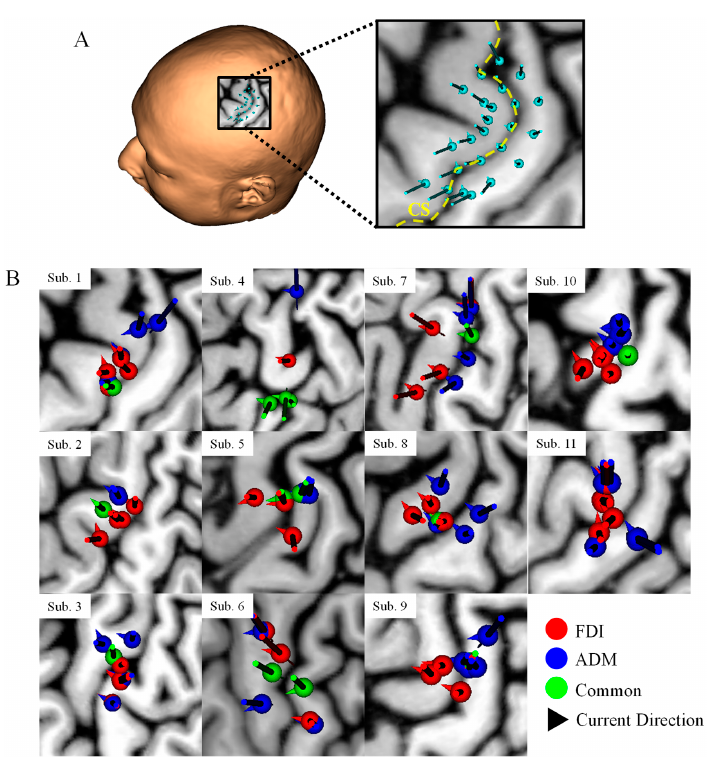
Figure A1. ( A ) TMS coil positions and orientations over the hand knob. The yellow dotted line indicates the central sulcus (CS). ( B ) Projection of the coil positions on the cerebral cortex that elicited the highest five MEPs for each participant. Red and blue dots represent the FDI and ADM, respectively. Green dots indicate the samples that were common to the two muscles. Arrows indicate the coil orientation. There is not clear distinction between the two target muscles based only on the coil position projection in most participants. In our study, MRI data is used as a priori information to guide the coil position and orientation (sulcus-aligned TMS coil) above the probable motor targets.